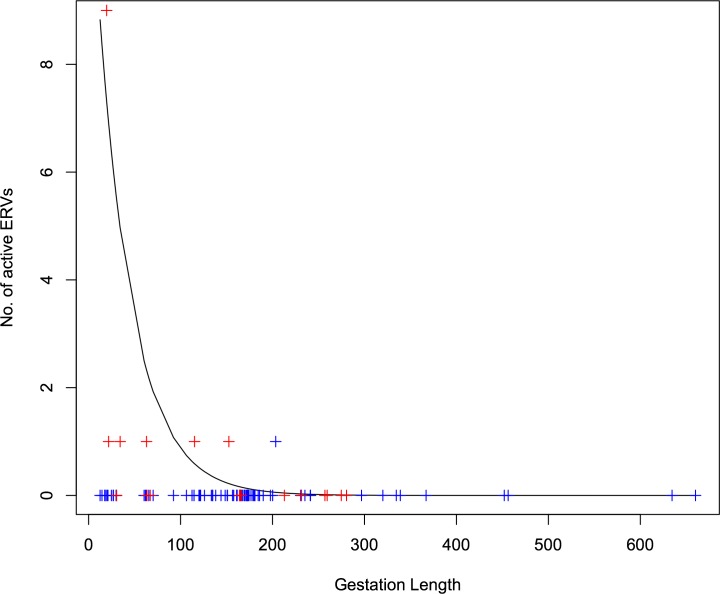
Predicted & observed number of active ERVs as a function of life history.Life history is approximated by gestation length (see Table 1). The black line represents the GLM predictions, whereas the crosses (blue and red) represent the actual data (from Table 1). Crosses in red indicate a high amount of “effort” (>10).